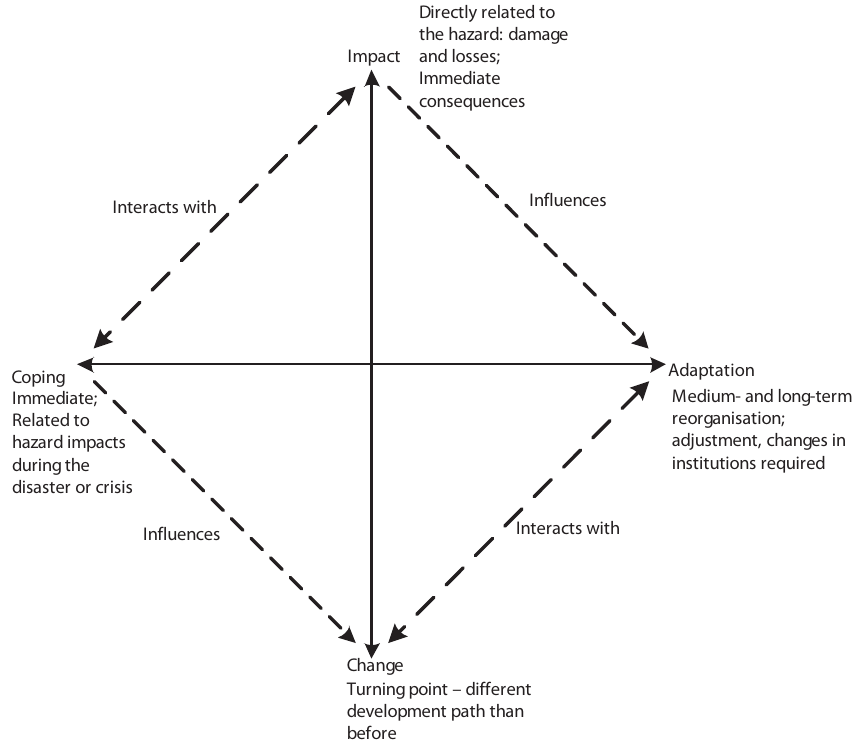
Fig. 2. Relation between coping, adaptation, impact and change (Based on Birkmann,